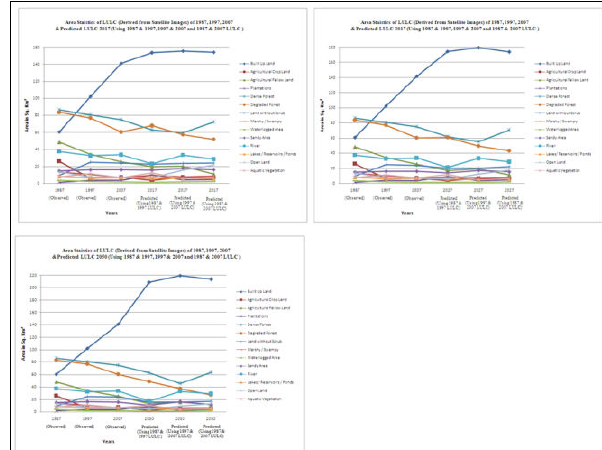
Figure 3. Line graphs represent area statistics of the observed